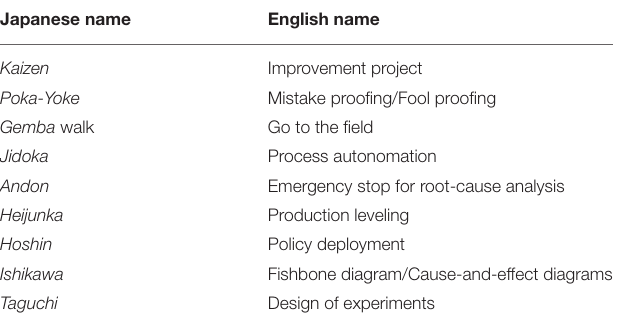
TABLE 8 | Tools synonyms in Japanese and